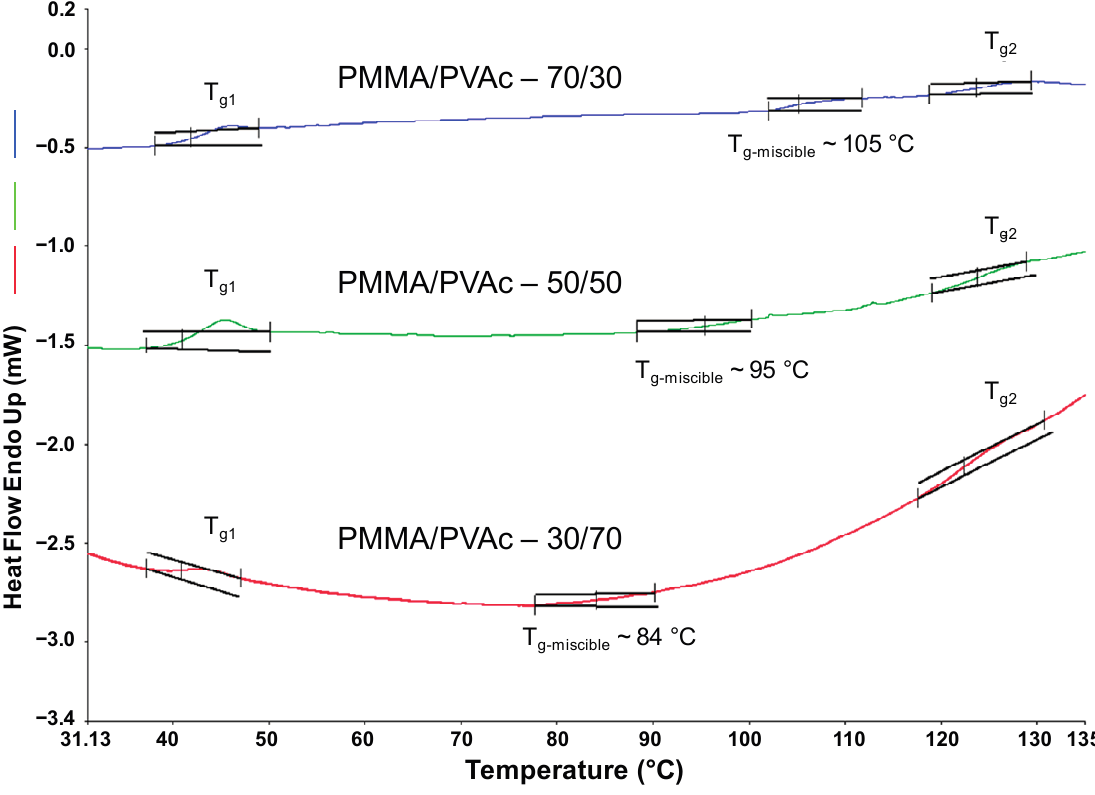
Figure 10. DSC heating scans of PMMA/PVAc blends coalesced from their stoichiometric U-ICs [34].